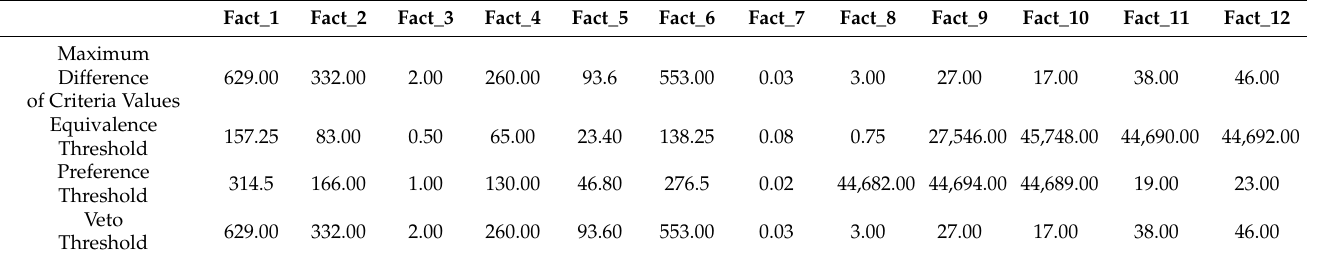
Table 10. The set of equivalence, preference, and veto thresholds from the point of view of the surveyed women.